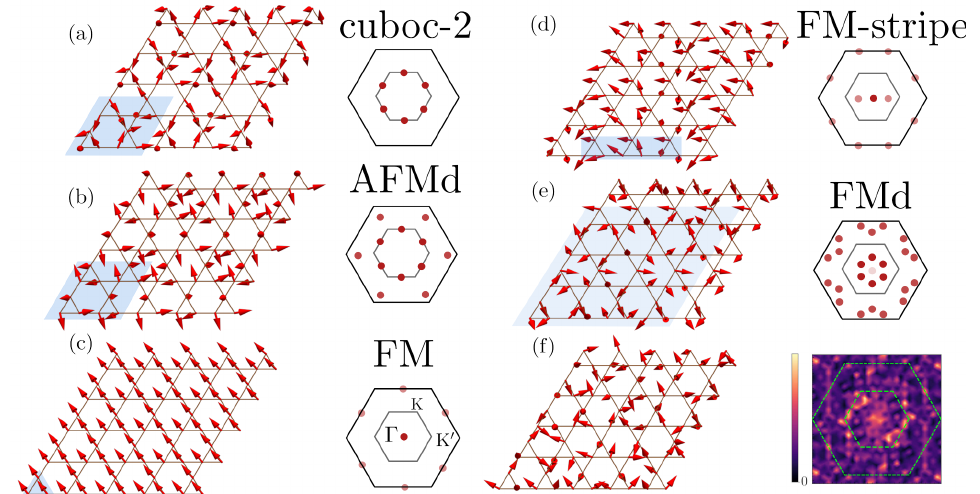
Figure 3: Classical spin configurations (left) and corresponding structure factor (right) for the phases in Fig. 2 with J χ = 1. The magnetic unit cell is marked by = − 0.05, J = 0.3); (c) FM; (d) the blue shaded region. (a) cuboc-2; (b) AFMd ( J d 1 = − 0.13, J = − 0.16); (e) FMd ( J = − 0.02, J = − 0.3); (f) classi- FM-stripe ( J d d 1 1 cally disordered region. The color scale on the right is arbitrary. All snapshots show a small portion of a L = 12 lattice. The inner (outer) hexagon in the structure factor represents the original (extended) Brillouin Zone of the kagome lattice. In addition, the darker (lighter) the dot, the stronger (weaker) the relative intensity of the Bragg peaks located at this position. The FM-stripe is stabilized in one of three equivalent configurations distinguished by a 2 π/ 3 rotation. The state shown in (f) is only one of the many possible states inside the disordered